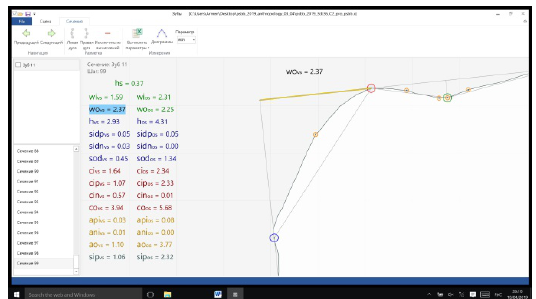
Figure 6. Tooth contour measurements